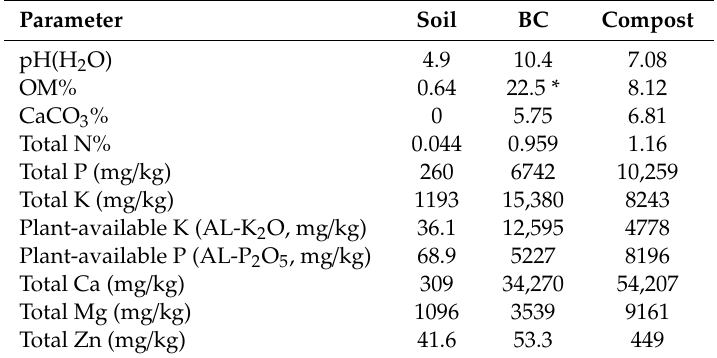
Table 1. Physical and chemical properties of the acidic sandy soil, biochar (BC) and compost. Parameter Soil BC Compost pH(H 2 O) 4.9 10.4 7.08 OM% 0.64 22.5 * 8.12 CaCO 3 % 0 5.75 6.81 Total N% 0.044 0.959 1.16 Total P (mg / kg) 260 6742 10,259 Total K (mg / kg) 1193 15,380 8243 Plant-available K (AL-K 2 O, mg / kg) 36.1 12,595 4778 Plant-available P (AL-P 2 O 5 , mg / kg) 68.9 5227 8196 Total Ca (mg / kg) 309 34,270 54,207 Total Mg (mg / kg) 1096 3539 9161 Total Zn (mg / kg) 41.6 53.3